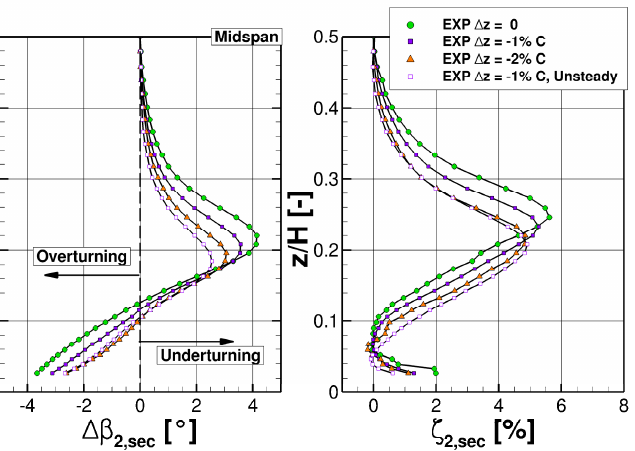
Figure 22. Measured spanwise distributions of the pitchwise-averaged secondary pitch angle ∆ β 2, sec and secondary total pressure losses ζ 2, sec under different endwall boundary layer conditions, with and without periodically incoming wakes in MP2.